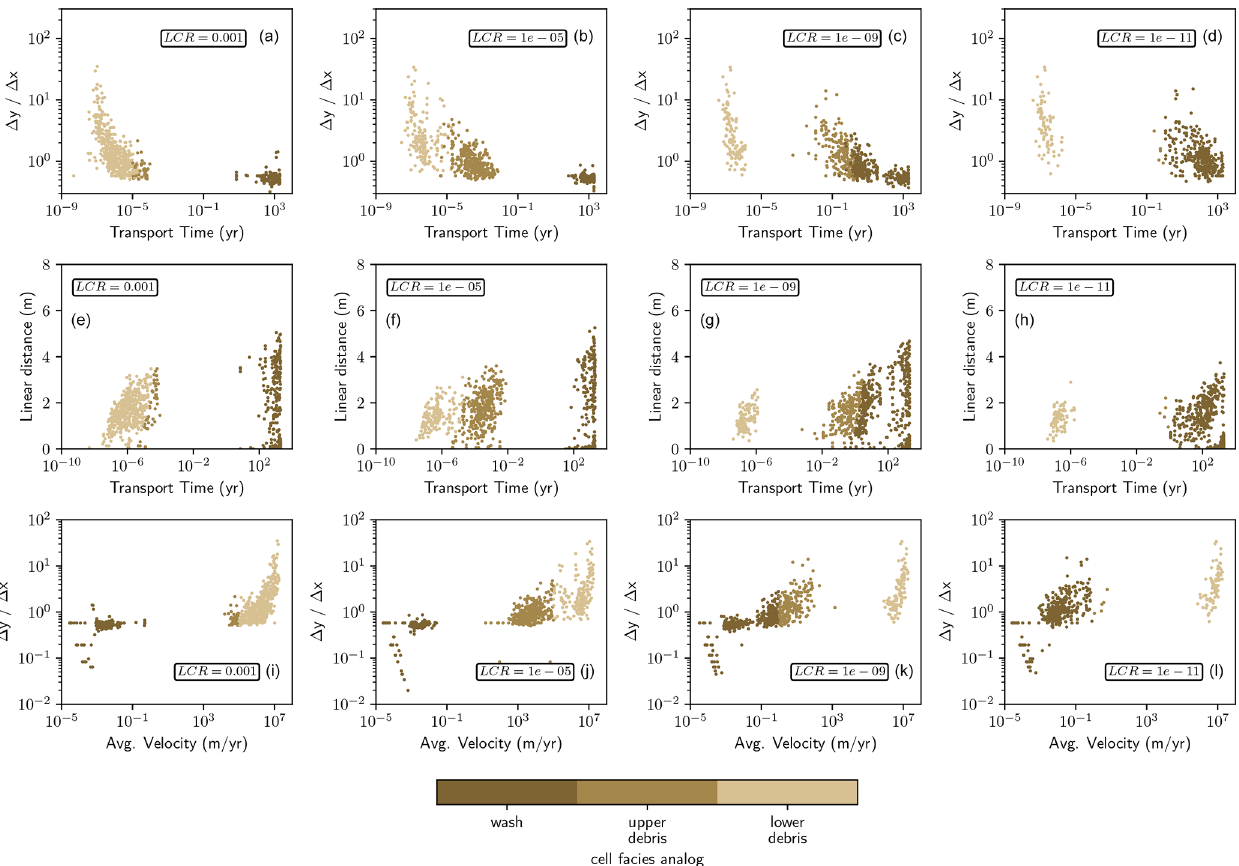
Figure 8. Scatterplots of the various transport histories of mobile regolith cells (total transport time, transport index ( (cid:49)y/(cid:49)x ), and average transport velocity). (a–d) Transport time versus transport index for various lateral collapse rates (LCRs). (e–h) Transport time versus linear distance for various lateral collapse rates. (i–l) Average transport velocity versus transport index. The scatterplots appear to show natural groupings of cells with similar transport histories. The color indicates our interpreted groupings of cells into analogs for the various sedimen- tary facies in the colluvial wedge model. These groupings are arbitrarily divided by the transport velocity with values greater than 10 5 md − 1 being “lower debris” analog facies and cells with values lower than 1md − 1 being “wash” facies analogs. Cells between these values are classified as “upper-debris-facies”